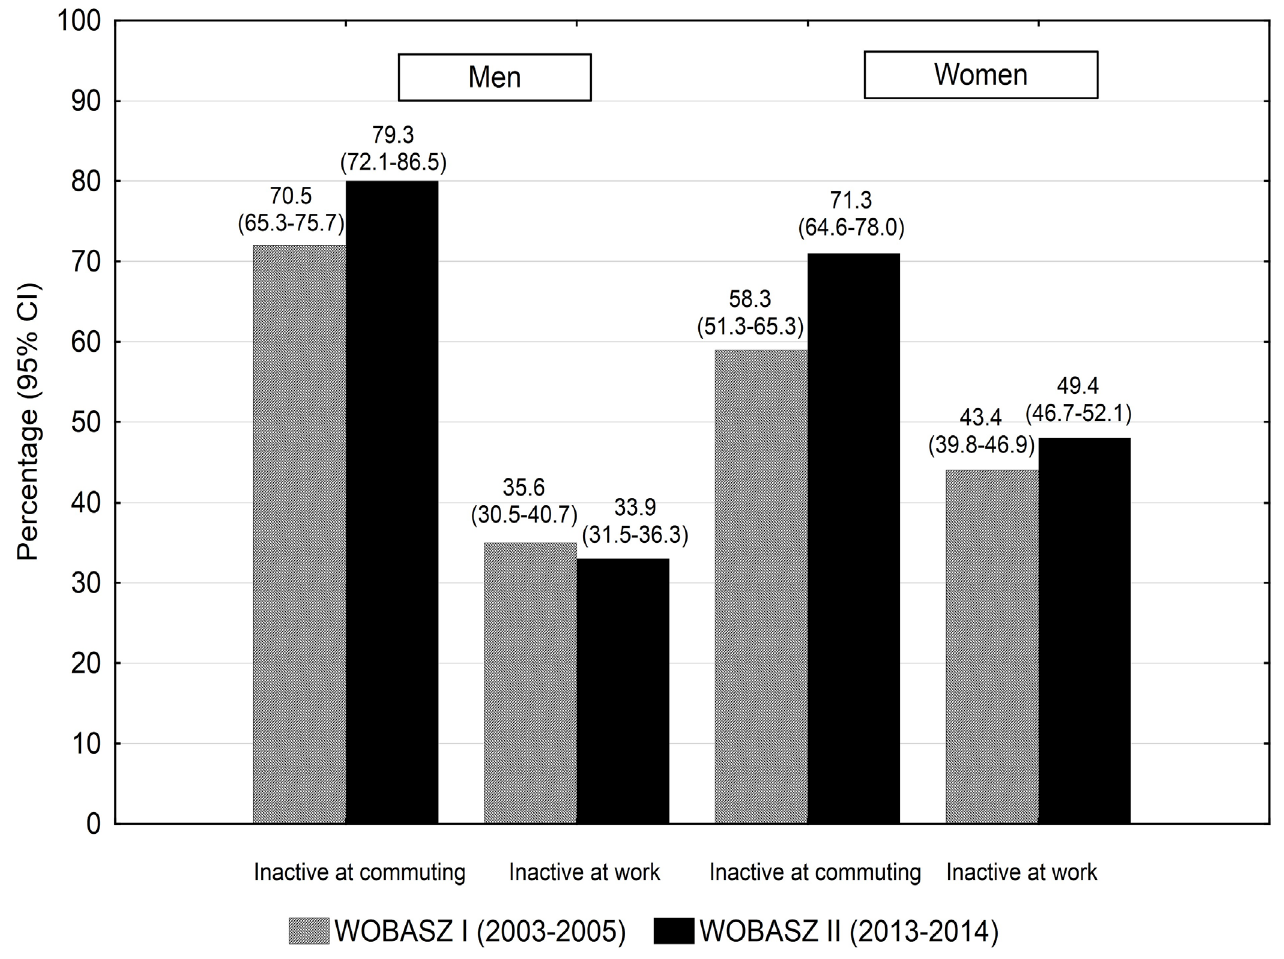
Fig 3. Changes in commuting and occupational inactivity among the participants of the WOBASZ